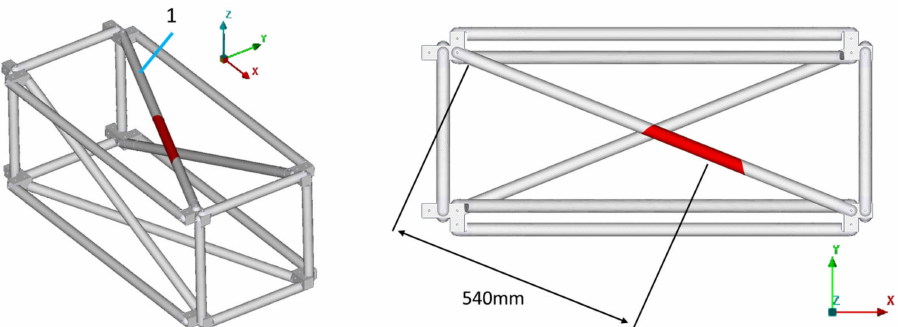
Figure 16. D1: Damaged FE